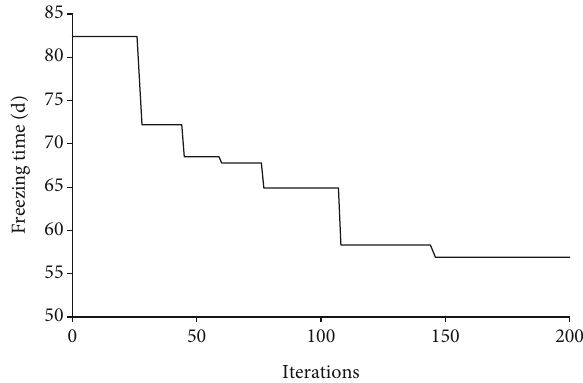
Figure 6: Iteration process of AOC